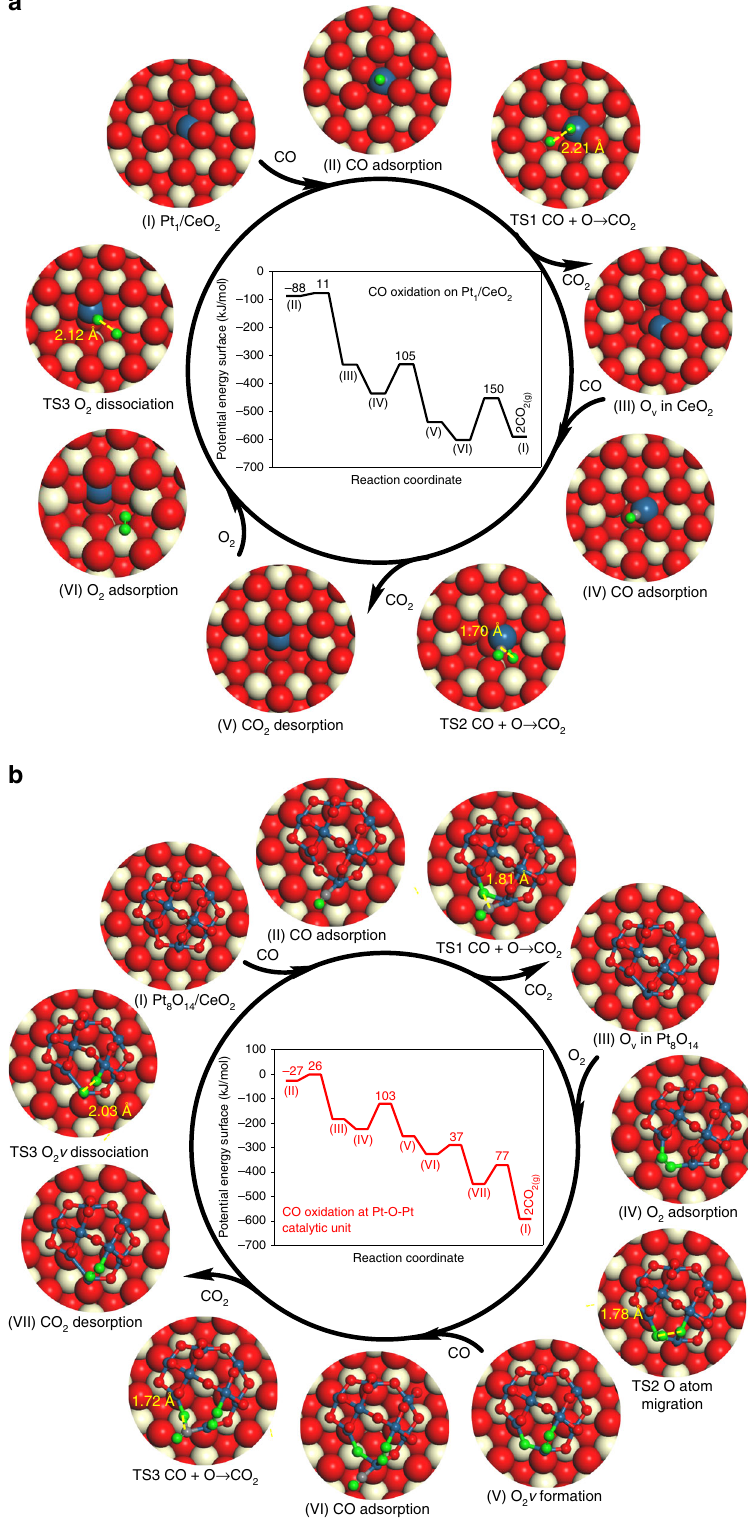
Fig. 3 Potential energy diagrams and con fi gurations for CO oxidation cycle. CO oxidation proceeds on a the Pt 1 /CeO 2 and b at the Pt-O-Pt catalytic unit in Pt 8 O 14 /CeO 2 . CO adsorption energies and reaction barriers are indicated in kJ/mol in the potential energy diagram. The bond distance between the two fragments at the transition state (TS) is given in angstrom (Å) in the con fi gurations of CO oxidation. Beige, red, and blue spheres are Ce, O, and Pt atoms, respectively. The small gray and green spheres are C and O atoms involved in CO oxidation. Corresponding energetics are given in Supplementary Table